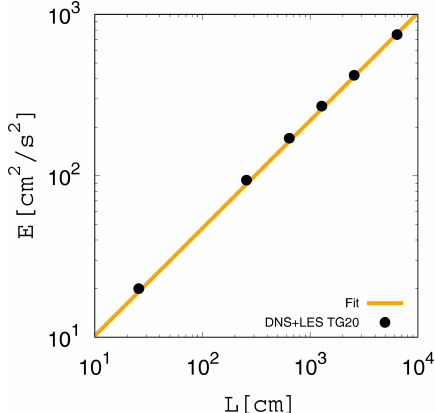
Figure B1. Relationship between the integral scale L and the turbu- lent kinetic energy E . The black dots are taken from the reference data in Thomas et al. (2020). The orange curve indicates the fitting function E = αε 2 / 3 L 2 / 3 with α = 0 .